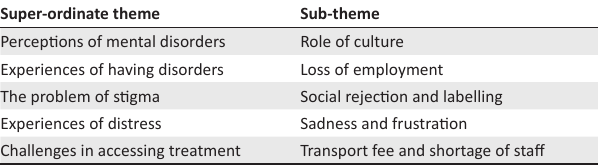
TABLE 2: List of super-ordinate and